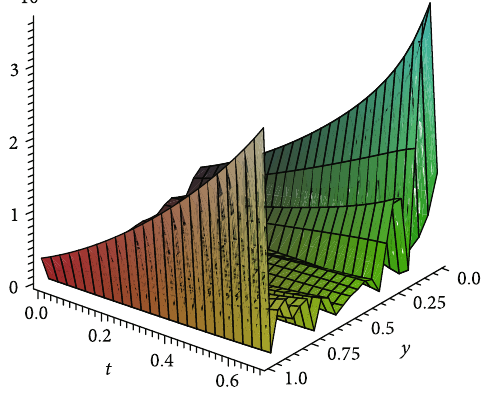
, where g ð x Þ = C